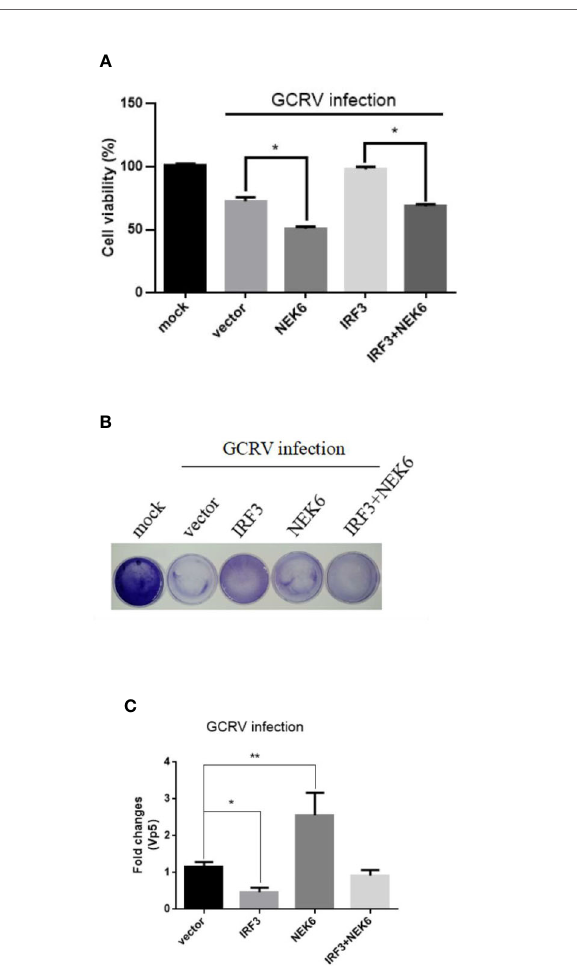
FIGURE 9 | CiNEK6 enhances GCRV proliferation in CIK cells. CIK cells were separately transfected with 2 m g of NEK6-pcDNA3.1 and 2 m g of IRF3- pcDNA3.1. At 24 h post-transfection, the cells were treated with GCRV and continue to be cultured for 24 h. This experiment was divided into three groups. One group of cell viability in 96-well plates was analyzed by CCK assay (A) . The second group of cells in 35-cm 2 dishes was stained with crystal violet for CPEs (B) . The third group of cells in six-well plates was used to abstracted total RNA, the mRNA level of Vp5 was detected by qRT-PCR (C) . *p< 0.05, ** p <